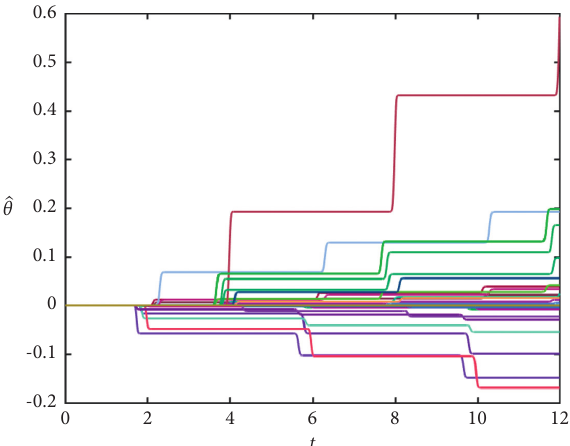
Figure 13: Weights estimates 􏽢 θ for Example